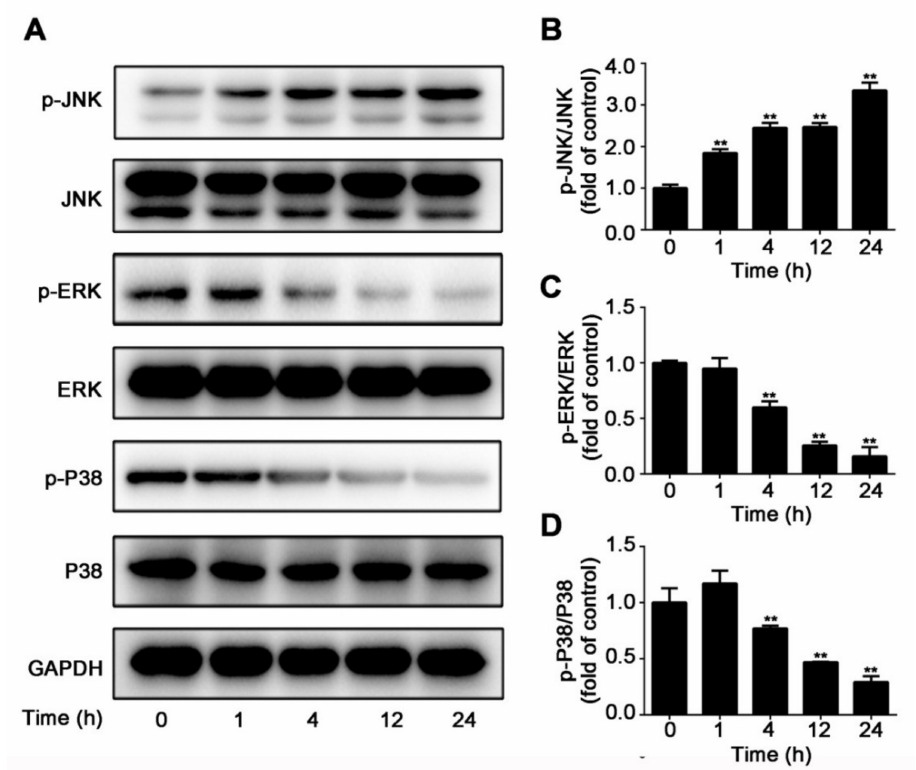
Figure 4. CuE regulated JNK, ERK, and p38 MAPKs in Huh7 cells. Cells were treated with CuE (40 nM) for various time (0, 1, 4, 12, and 24 h). ( A ) Phosphorylations of JNK, ERK, and p38 protein were determined by Western blot assay. ( B – D ) Quantitative analysis for relative phosphorylation levels of JNK ( B ), ERK ( C ), and p38 MAPK ( D ) was performed by normalizing to the control group. Data are mean ± SD of three independent experiments (n = 3). **: p < 0.01, compared with the control